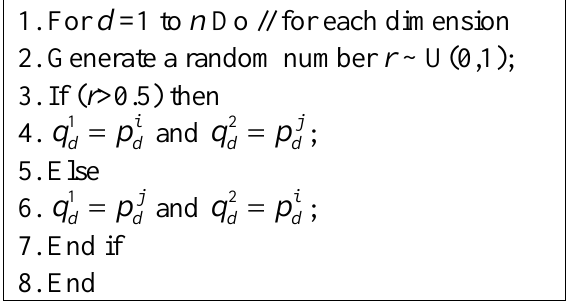
Figure 5. Uniform crossover of two